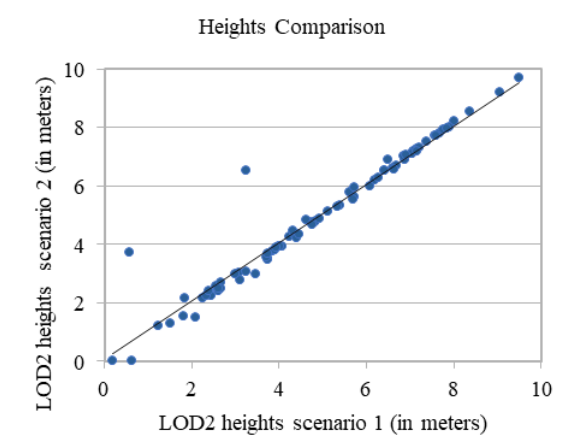
Figure 10. Heights comparison of LOD2 buildings between the two scenarios